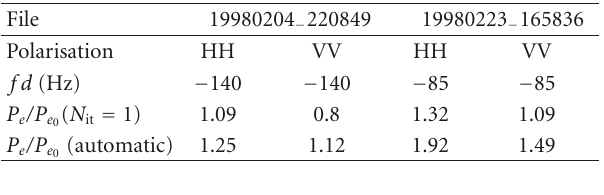
for N = 8, K = 24, and B = 50. 0